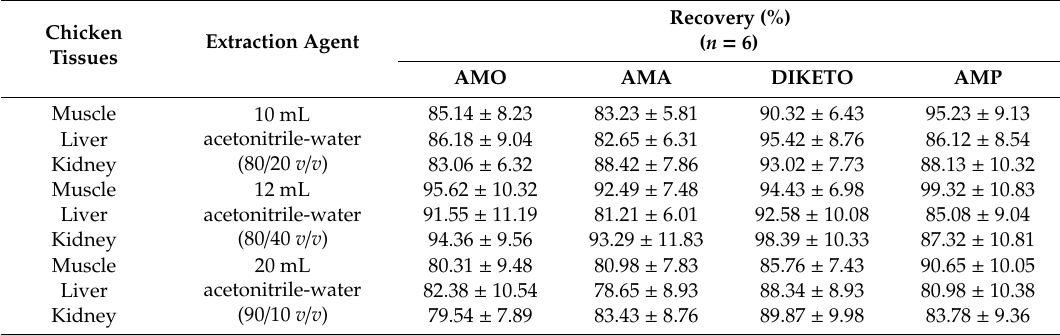
Table 1. Comparison of the recovery of 50 µ g / kg the target analytes in the three matrices with di ff erent proportions of the